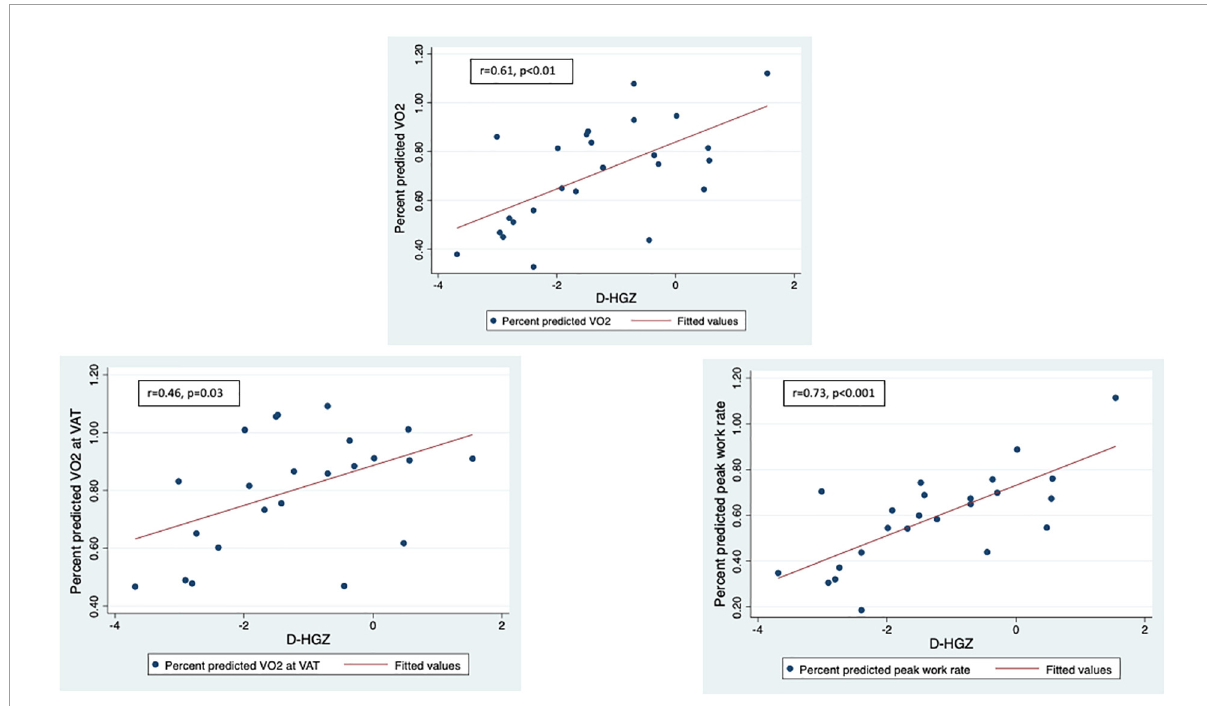
FIGURE2 LLMZ, D-HGZ, and PAQ score were associated with percent predicted peak VO 2 , percent predicted VO 2 at VAT, and percent predicted work. This figure demonstrates the associations between D-HGZ and CPET parameters.